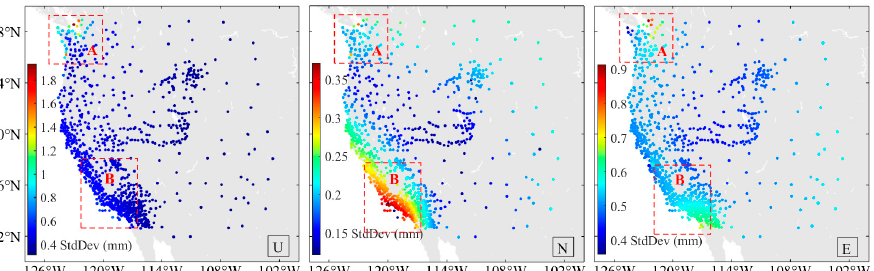
Figure 4. StdDev maps of the difference of the OTL displacements estimated by the proposed tide calculation method and FES2014b+osu.usawest model in U, N, and E directions, and the areas with lager difference (red box).